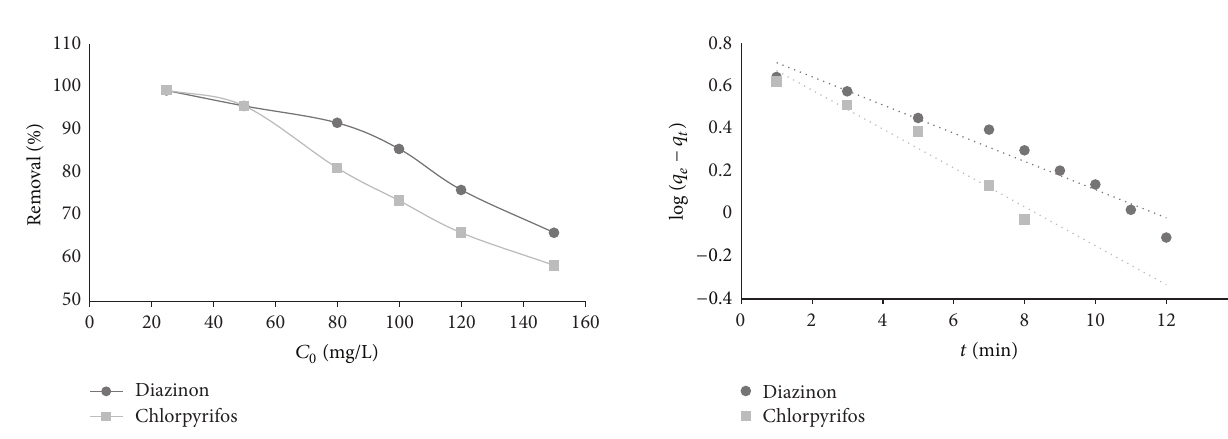
Figure 5: Pseudo first-order kinetic model for adsorption of diazinon and chlorpyrifos by TNP.